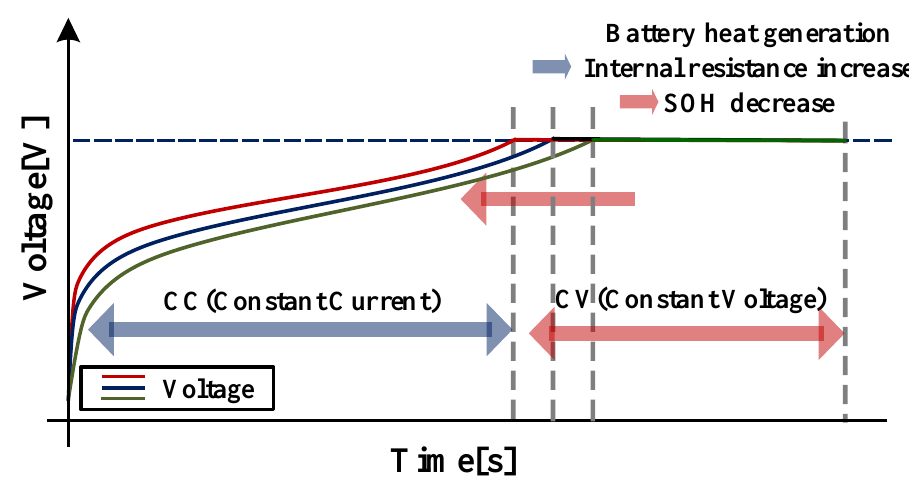
Figure 6. SoH change according to charging time.